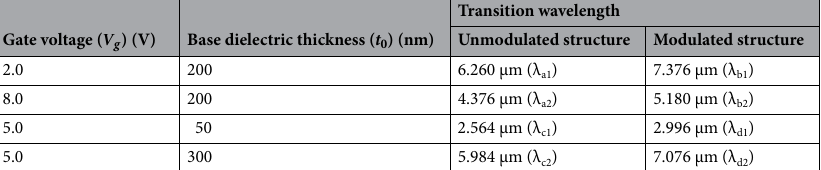
Gate voltage ( V g )